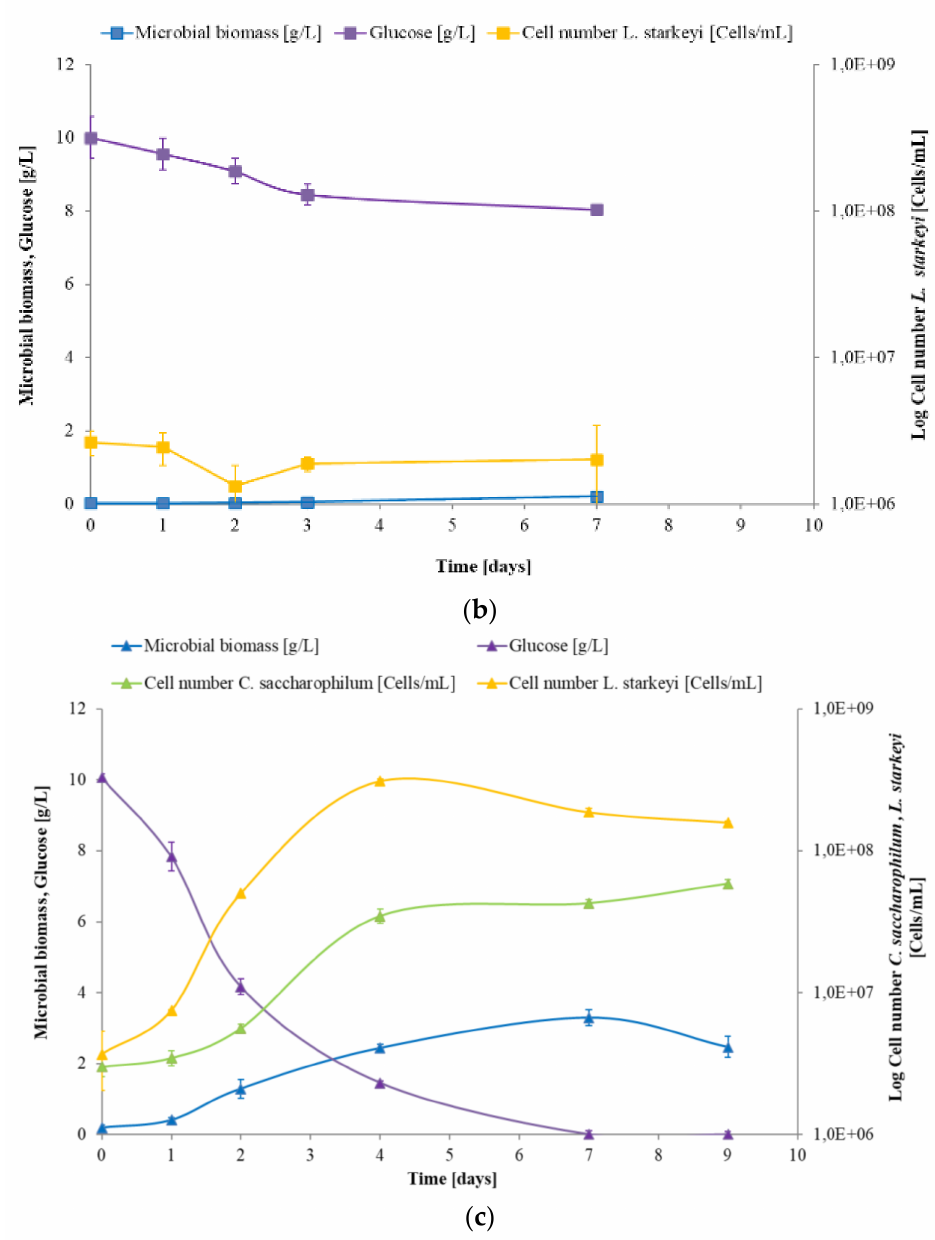
Figure 1. ( a , b ) Profiles of microbial biomass (g/L), glucose consumption (g/L) and cell number (cells/mL) in BBM + G medium supplemented with yeast extract and glucose inoculated by C. saccha- rophilum ( a ) and L. starkeyi ( b ). ( c ) Profiles of microbial biomass (g/L), glucose consumption (g/L) and cell number (cells/mL) in BBM + G medium supplemented with yeast extract and glucose inoculated by C. saccharophilum and L. starkeyi in mixed